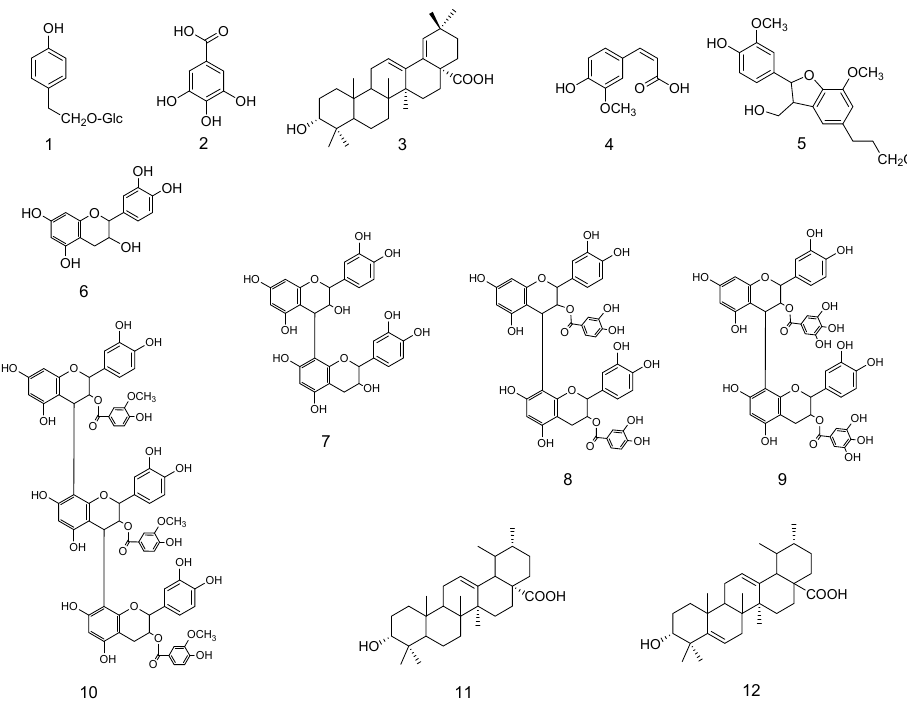
Figure 3. Isolated compounds.